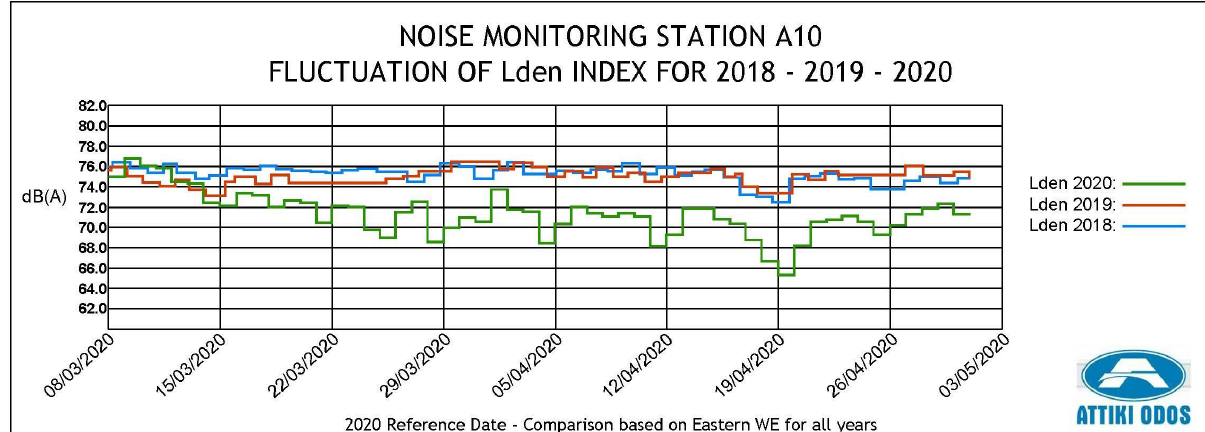
Figure 9d: Fluctuation of L den index – Noise monitoring station A10